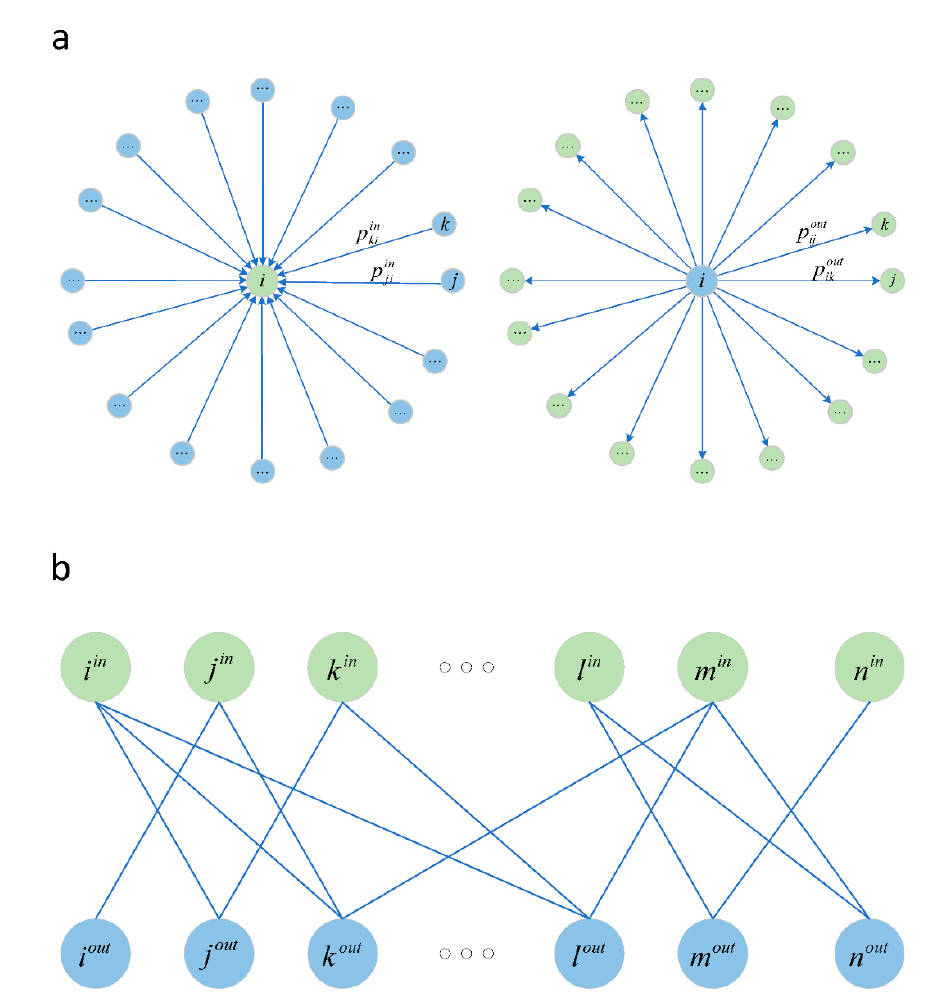
Figure 2. Network structure transformed from migration proportion data. ( a ) A star network; ( b ) a two-part network.